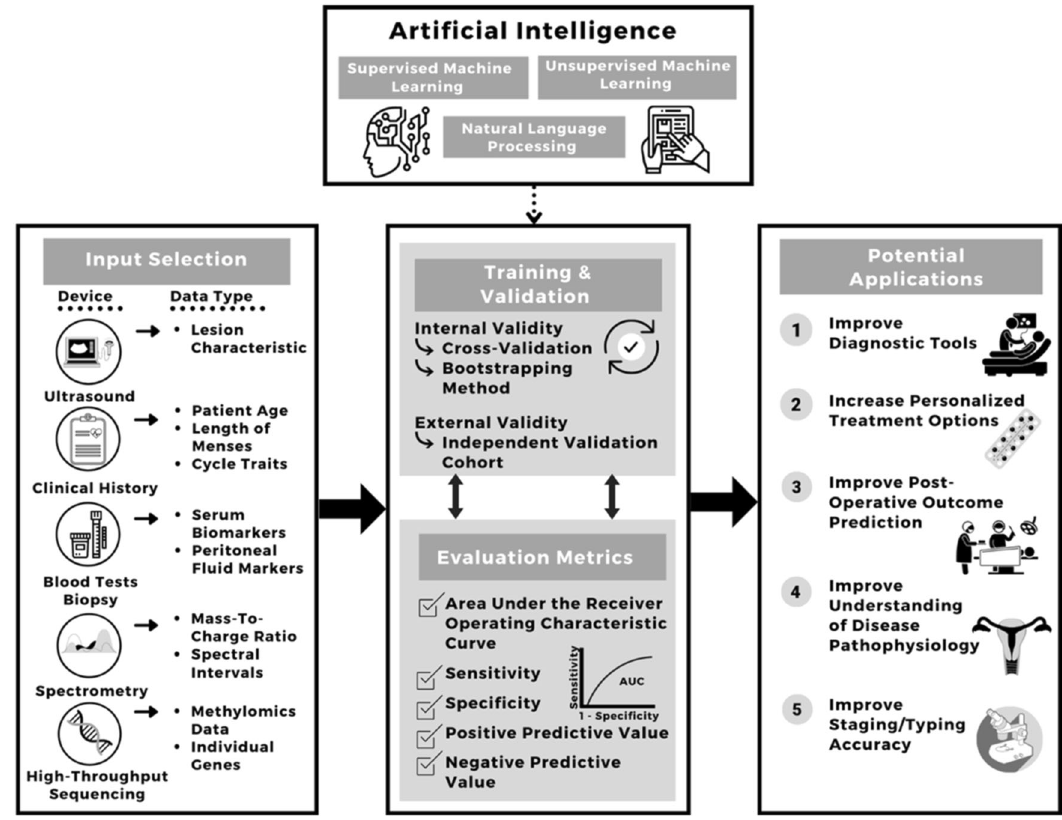
Fig. 1 Potential area of use for arti fi cial intelligence applications in endometriosis. This fi gure was created by B.S. and